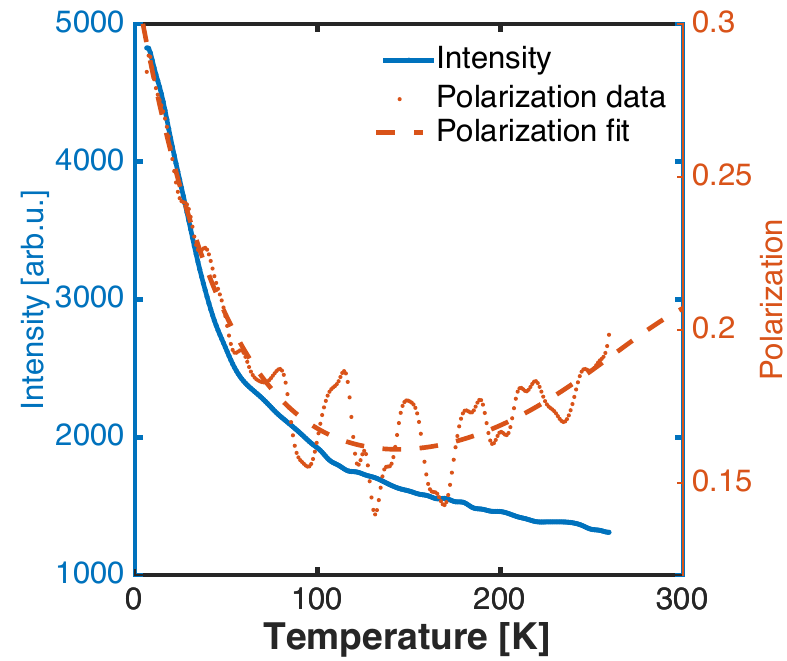
Figure 5. Temperature dependence of the intensity (blue) and the polarization (orange) as measured at q = 0.06 Å − 1 at RESEDA. The data are recorded during the course of cooling down the sample. Data recorded during heating up the sample give similar results (not shown), thus hysteresis effects do not play a